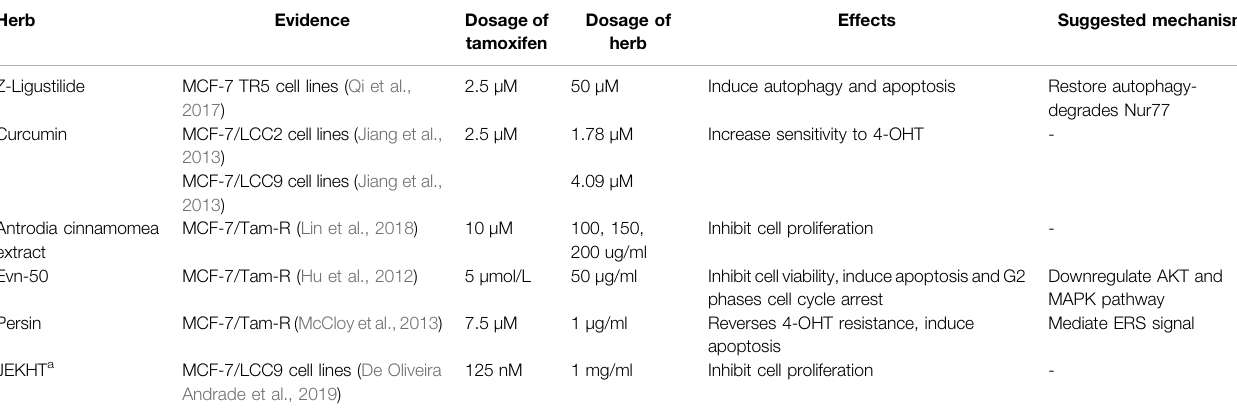
TABLE 4 | Reported evidence of increasing